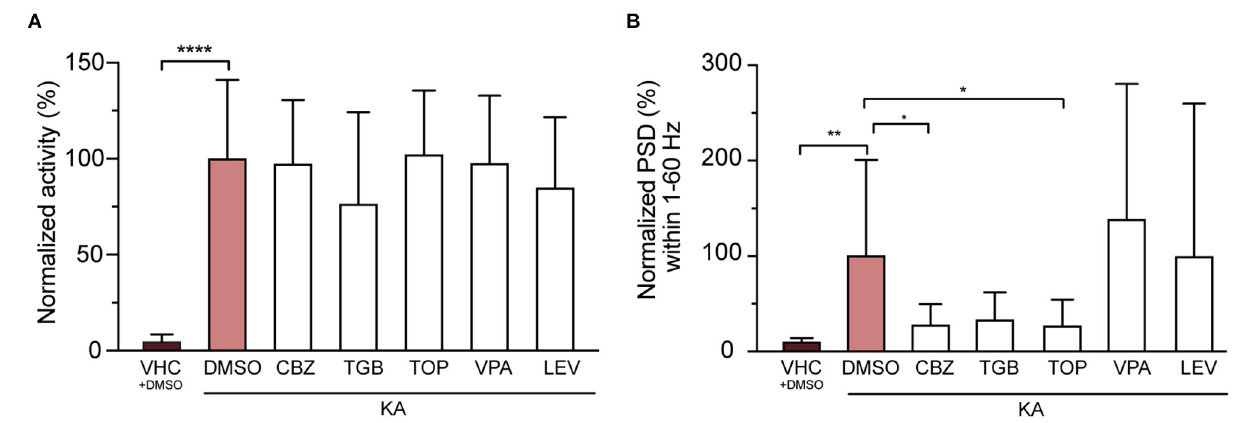
FIGURE 6 | Three out of five tested anti-epileptic drugs (AEDs) rescue epileptiform brain discharges but not seizure-like behavior. (A) Quantification of seizure-like behavior at 3 dpi after incubation of VHC- and KA-injected larvae with commonly used AEDs or DMSO control for 24h. None of the tested compounds decreased seizure-like behavior (tail twitching). Values were normalized to KA-injected controls treated with 1% DMSO as 100%. Total number of larvae per condition: VHC + DMSO n = 20, KA + DMSO n = 18, KA + CBZ n = 15, KA + TGB n = 15, KA + TOP n = 15, KA + VPA n = 15, KA + LEV n = 12. Data are presented as mean ± s.d. Statistical analysis was performed using ordinary one-way Anova with Bonferroni’s multiple comparison test (**** p < 0.0001). (B) Mean power spectral density (PSD) values from LFP recordings at 3 dpi plotted per condition over the 1–60Hz region for VHC- and KA-injected larvae after incubation with AEDs or DMSO control for 24h. Values were normalized to KA-injected controls treated with 1% DMSO as 100%. CBZ (* p = 0.04), TGB (ns, p = 0.05) and TOP (* p = 0.03) decreased epileptiform brain activity in KA-injected larvae (VHC ** p = 0.001), while VPA and LEV did not have any effect. Total number of larvae per condition: VHC + DMSO n = 18, KA + DMSO n = 38, KA + CBZ n = 15, KA + TGB n = 14, KA + TOP n = 14, KA + VPA n = 11, KA + LEV n = 12. Data are presented as mean ± s.d. Statistical analysis was performed using ordinary one-way Anova with Bonferroni’s multiple comparison test. CBZ, carbamazepine; TGB, tiagabine; TOP, topiramate; VPA, valproic acid; LEV,